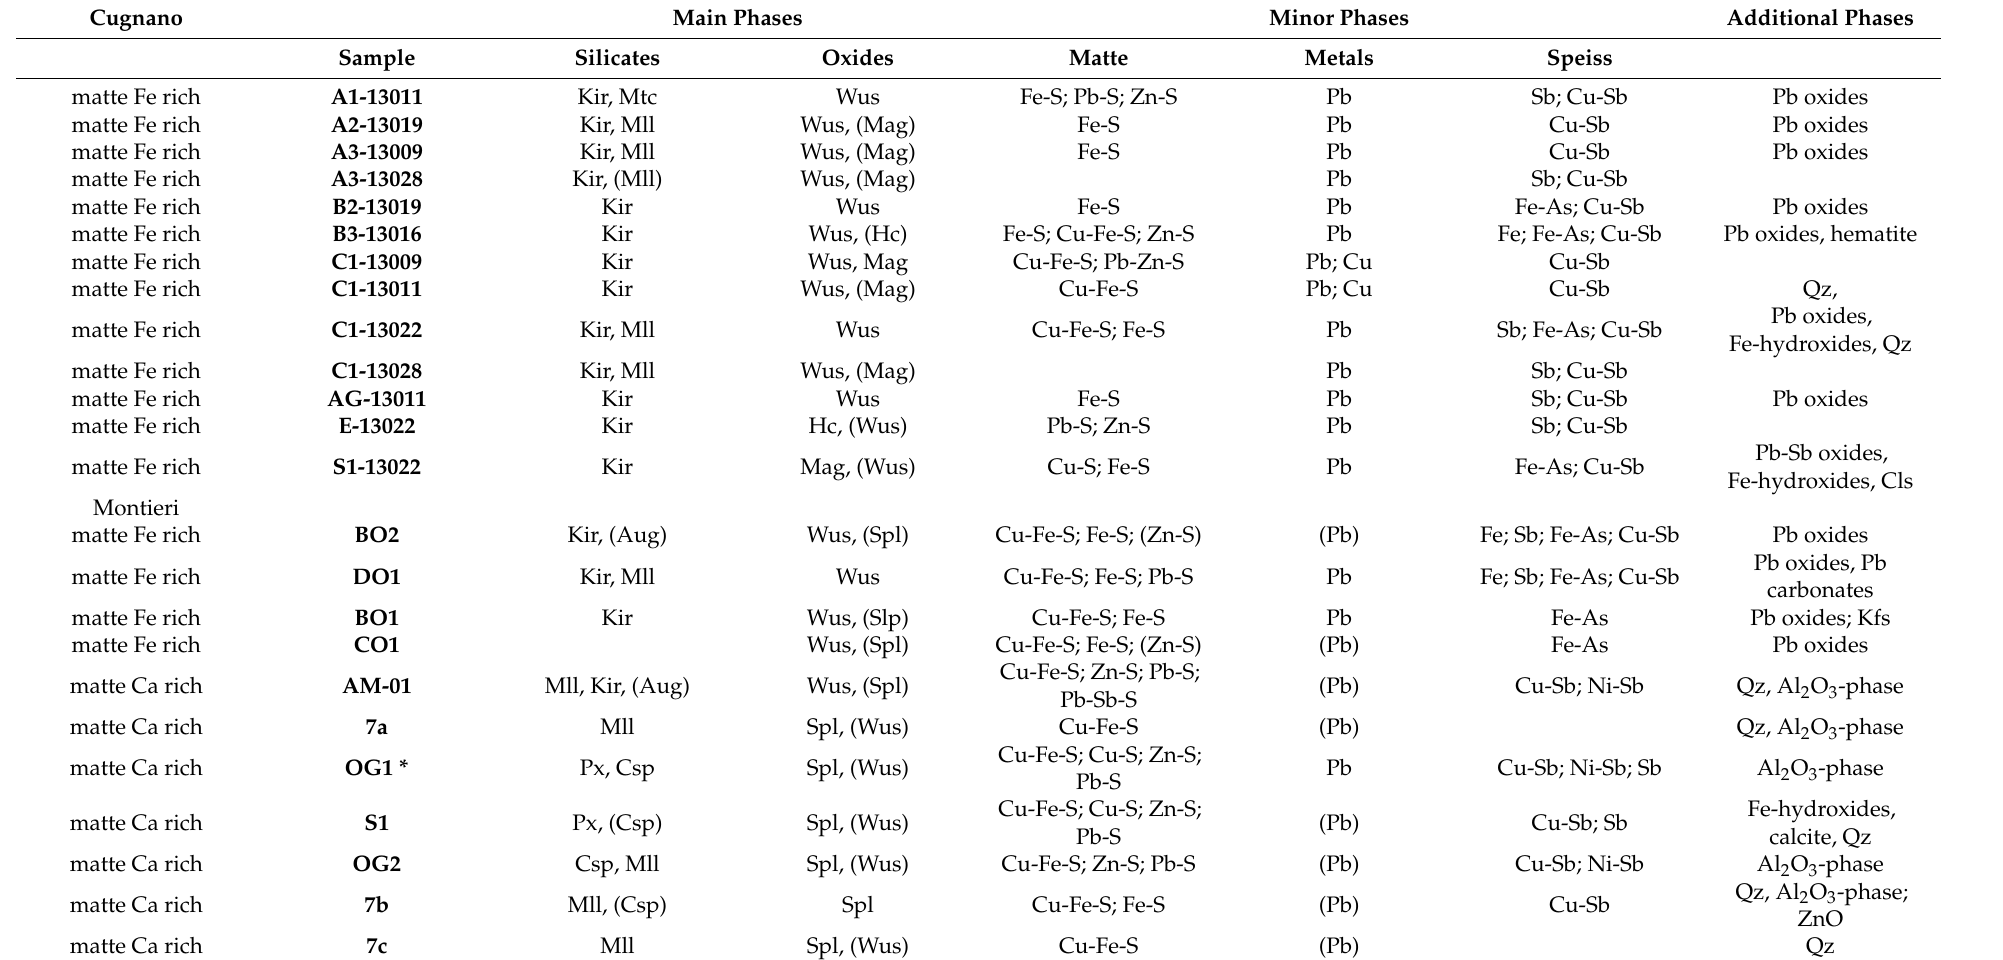
Table 4. Mineralogy of slags. Abbreviations: Kir—kirschsteinite; Mt—monticellite; Lrn—larnite; Mll—melilites; Wus—wüstite; Mag—magnetite; Hc—hercynite, Qz—quartz; Cls—celsian; Aug—augite; Spl—zoned spinels; Kfs—k-feldspati; Px—pyroxenes; Csp—cuspidine. Cugnano Main Phases